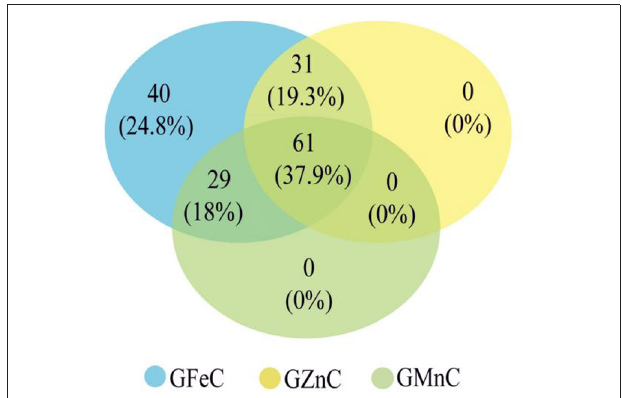
FIGURE 4 | Potential genotypes with high micronutrient concentrations selected from the RILs based on high-confidence MTAs associated with GFeC, GZnC, and